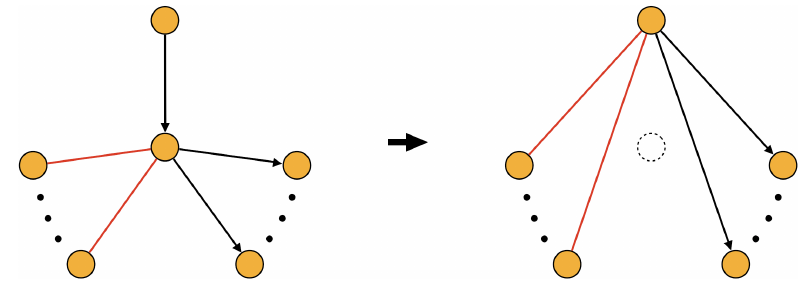
Figure 17 . A node with a single incoming chiral field is a BFT 2 bubble. Due to anomaly cancellation, = n F + 1 . The bubble is removed by triality. This process an also be interpreted as higgsing n χ k k,out with a non-zero VEV for the incoming